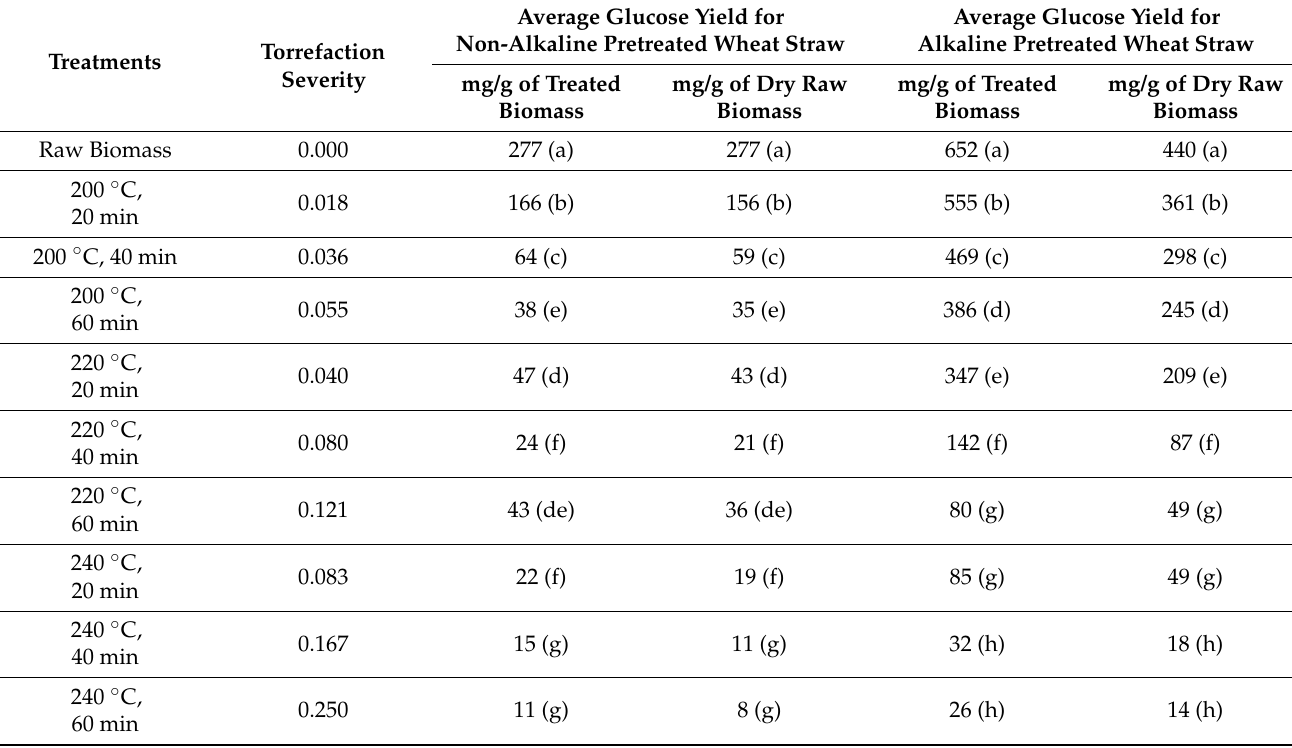
Table 2. Tukey’s HSD results for identifying significantly different